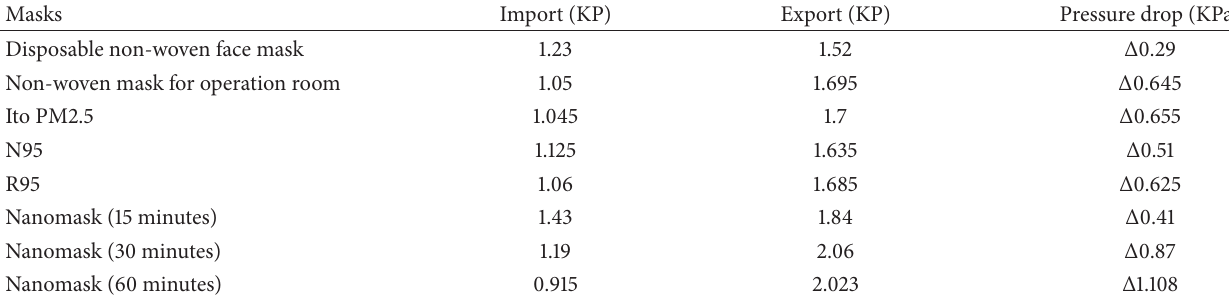
Table 2: The pressure drop statistics in permeability test.